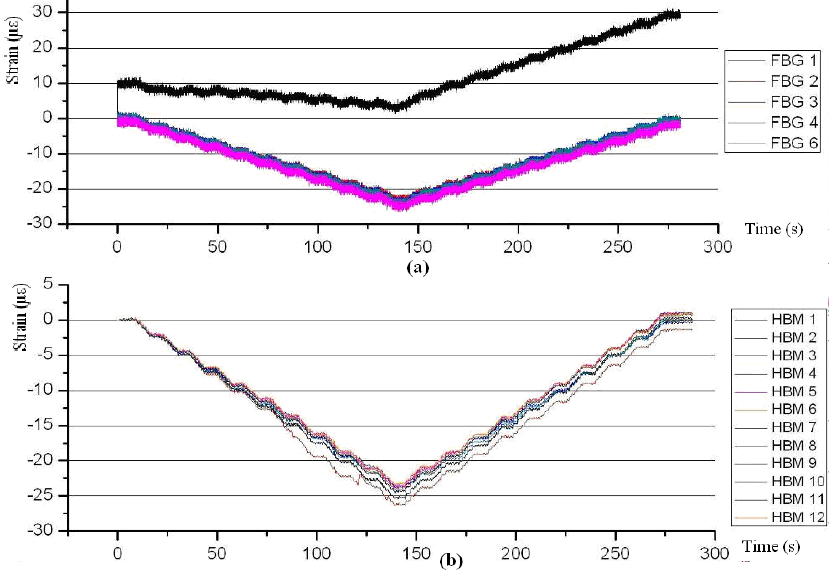
Figure 9. Specimen 1. Test before aging. 5kN Compression stress. FBGs (a) and strain gauges (b)